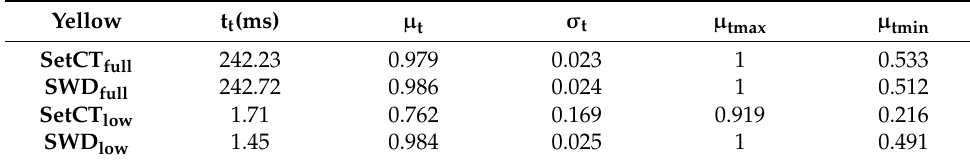
Table 6. Performance evaluation of the THz-FDS classification of a yellow sample.